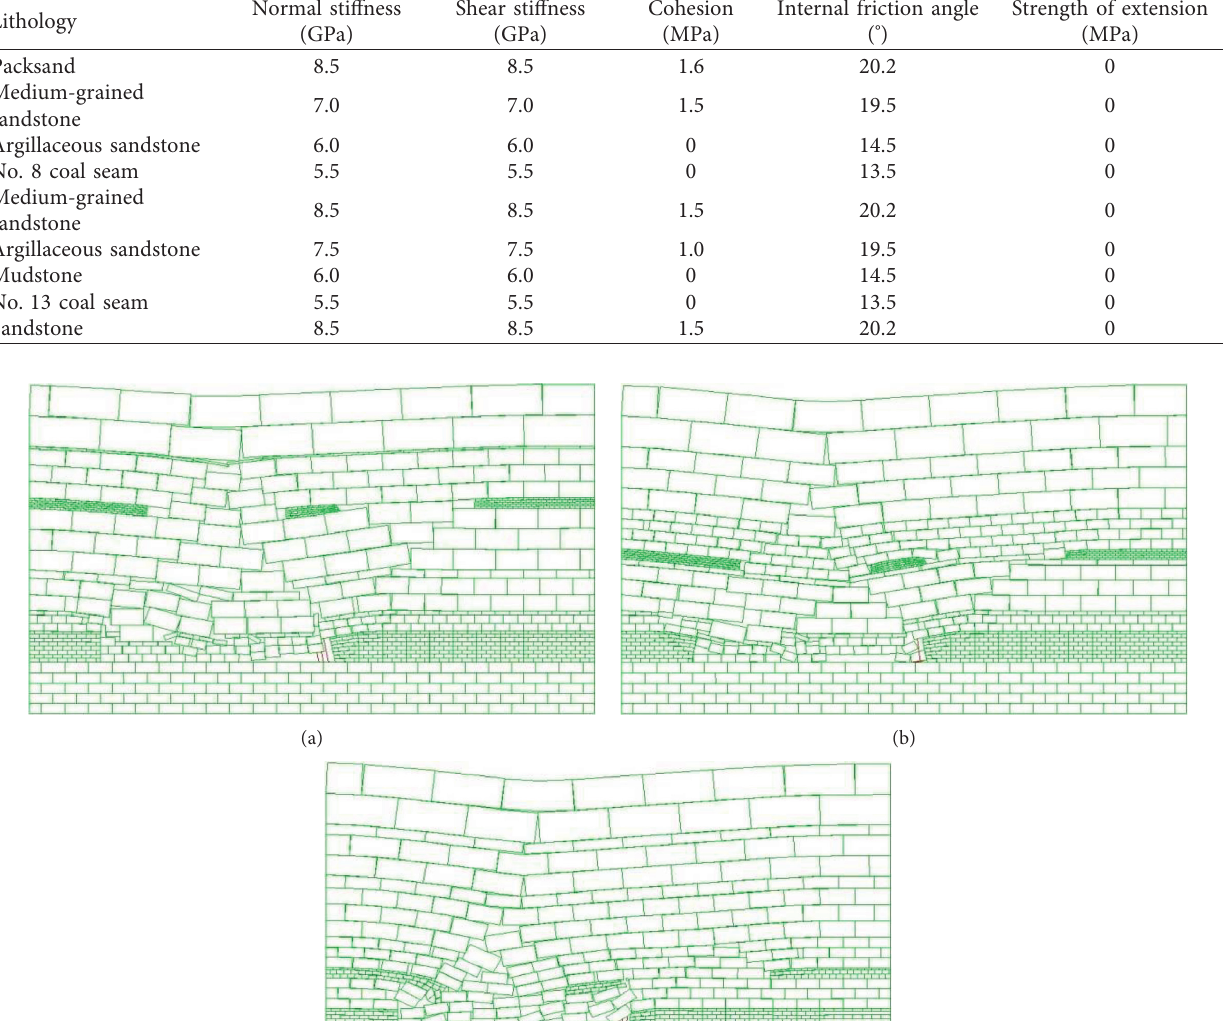
Table 1: The mechanical parameters of contact surface of coal and rock.